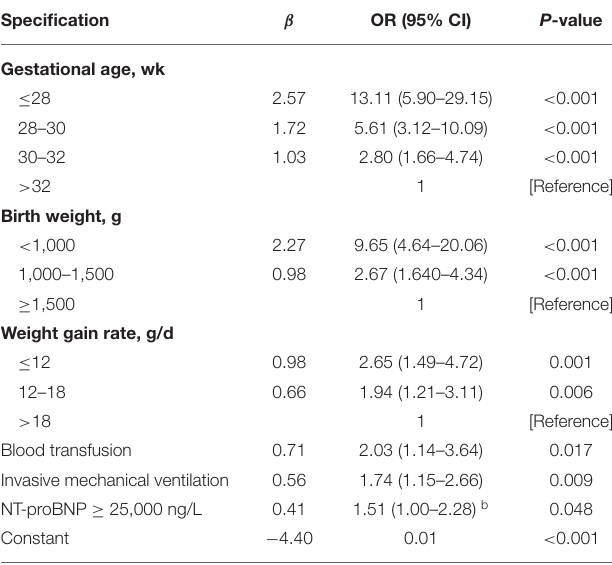
TABLE 3 | Multiple Logistic Regression Estimates Based on Backward Selection Eliminating from a Model with Known Risk Factors (Gestational Age, Birth Weight,) and Significant Risk Factors Reported in Table 2 a